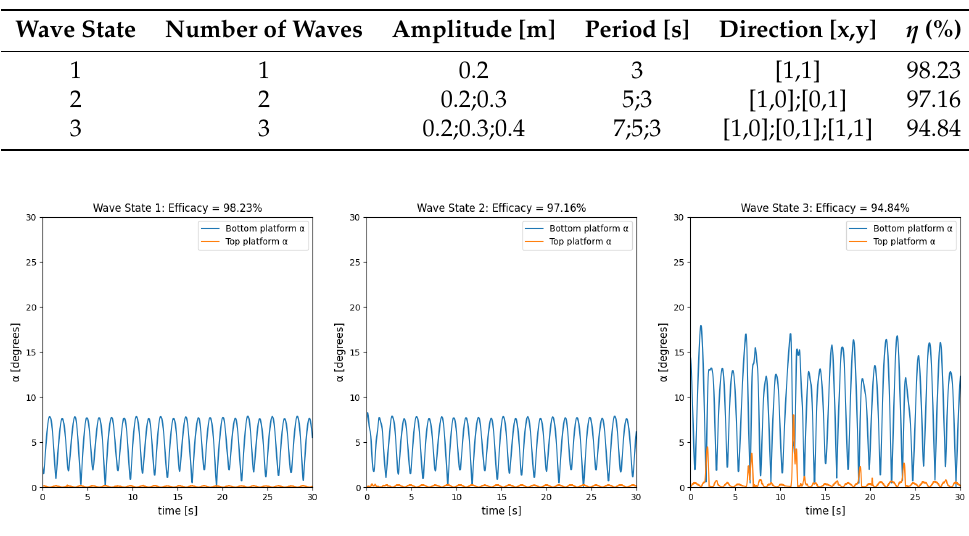
Table 2. Efficacy of the mechanism for different wave states.